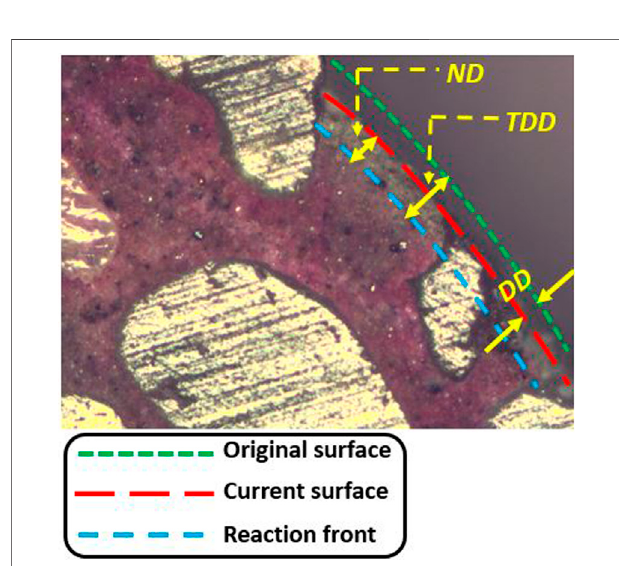
FIGURE 2 | Illustration of ND, DD, and TDD in a microscope image of 50Slag_50FA sample surface after the spray of phenolphthalein (immersion age was 28 days and the pH of acid was